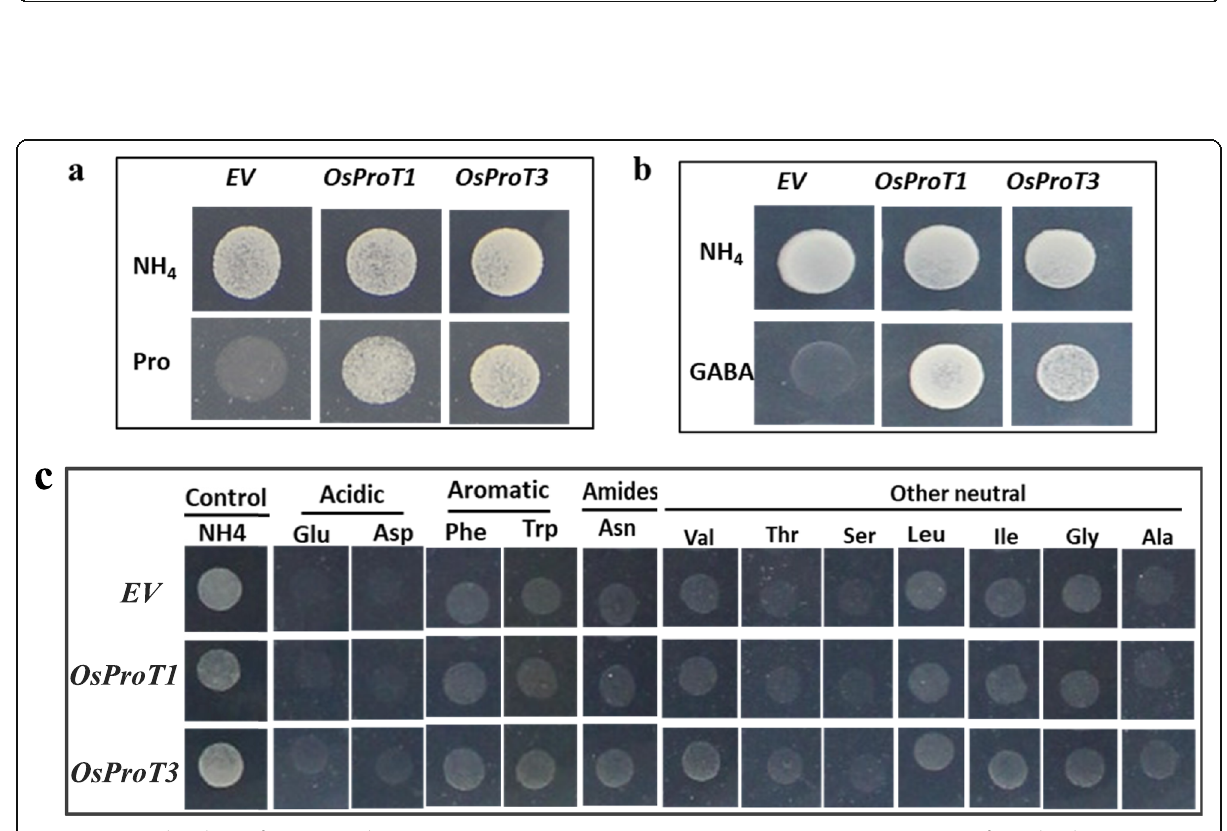
Fig. 3 Functional analyses of OsProT1 and OsProT3 in yeast mutant 22 △ 10 α . a-c, Yeast mutant strain 22 △ 10 α was transformed with p426GPD empty vector ( EV ) or the plasmid containing the coding sequence of OsProT1 or OsProT3 , and grown on SD plates with (NH 4 ) 2 SO 4 , Pro, GABA or other amino acid as the sole nitrogen source for about 4